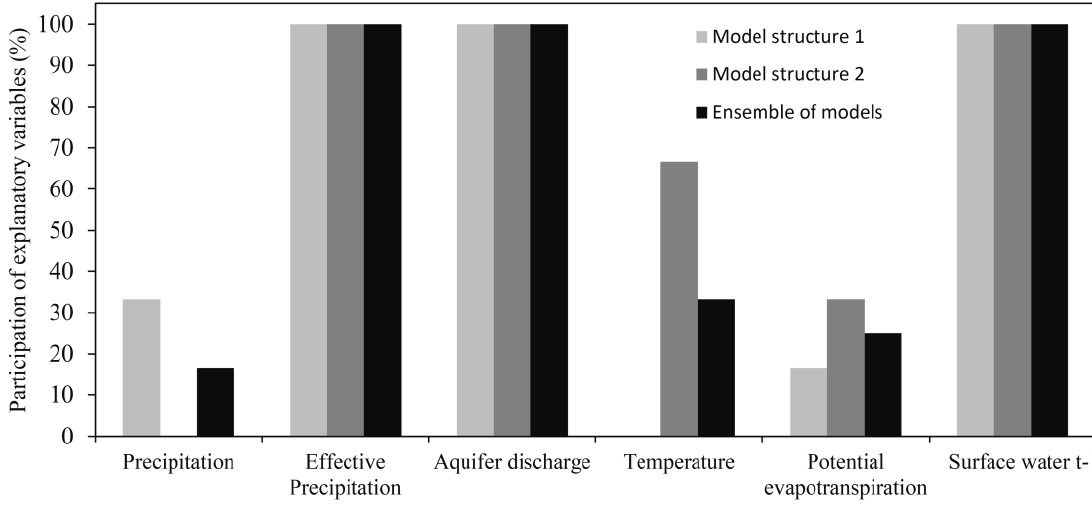
Figure 10. Participation of the explanatory variables in the regression models.